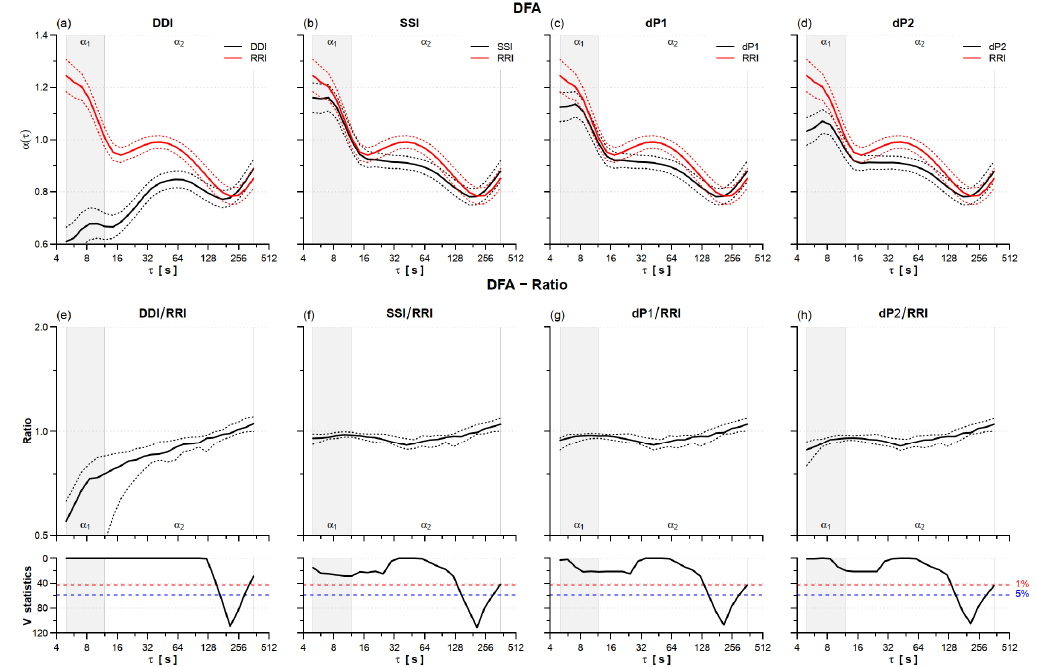
Figure 4. HRV detrended fluctuation analysis (DFA) sleeping at high altitude. Upper panels: mean (solid line) ± standard error (dotted line) for DFA spectra of DDI ( a ), SSI ( b ), dP1 ( c ), and dP2 ( d ) (black) and the reference RRI (red) on n = 21 participants. Lower panels: ratio between the DFA of DDI ( e ), SSI ( f ), dP1 ( g ), and dP2 ( h ) tachograms and the reference RRI: median (solid line) with 1st and 3rd quartiles (dotted line) and V-statistics of Wilcoxon rank test; at scales where the V-value is above the 5% (or 1%) significance threshold (dashed horizontal lines) the DFA ratio differs from 1 at the 5% (or 1%) statistical significance. Grey/white areas indicate the scales for evaluating α 1 and α 2 scale